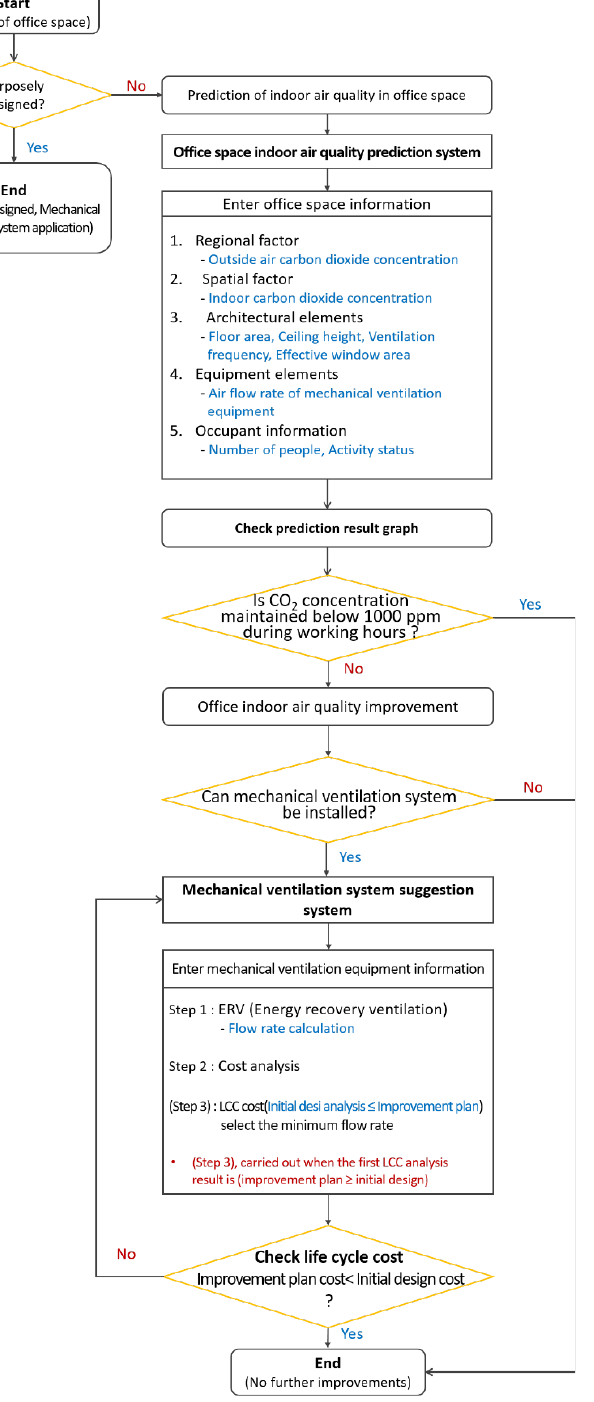
Figure 13. Office space indoor air quality prediction and mechanical ventilation system suggestion process diagram.